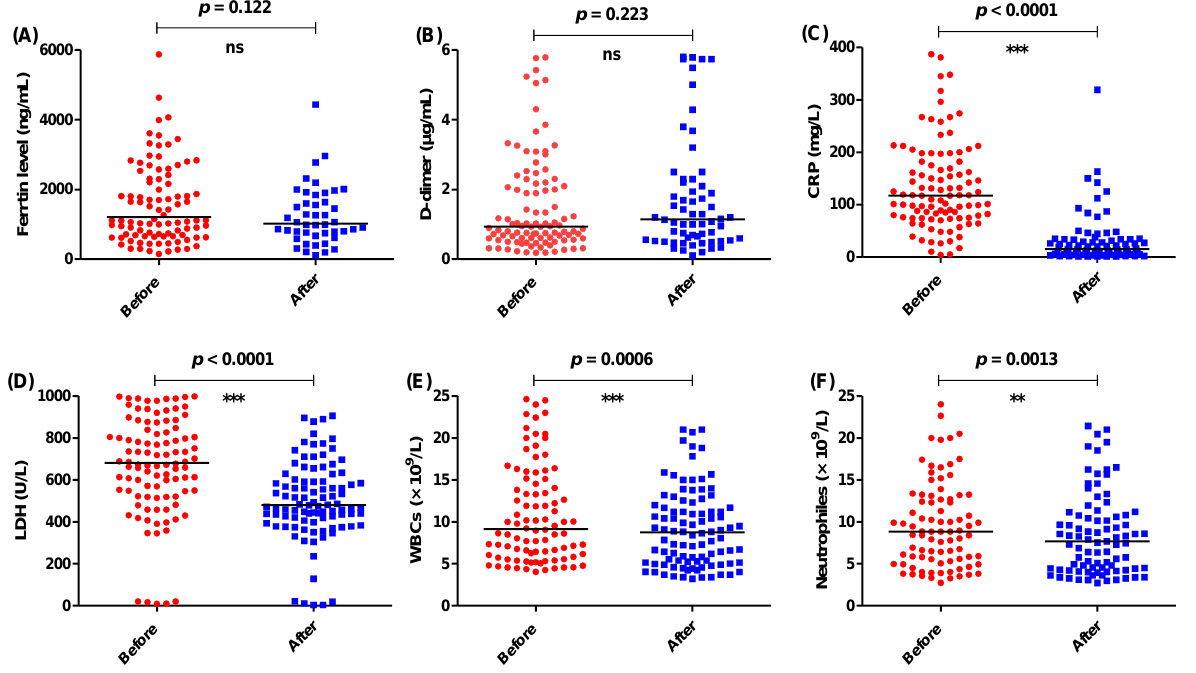
Figure 3. The levels of different parameters before and after the administration of the treatment regimen with interleukin-6 antagonist tocilizumab. The levels of ( A ) ferritin, ( B ) D-dimer, ( C ) CRP, ( D ) LDH, ( E ) WBCs, and ( F ) neutrophiles were measured before and after completion of treatment regimen. *** = p ≤ 0.001, ** = p < 0.01, and ns (nonsignificant) p > 0.05.